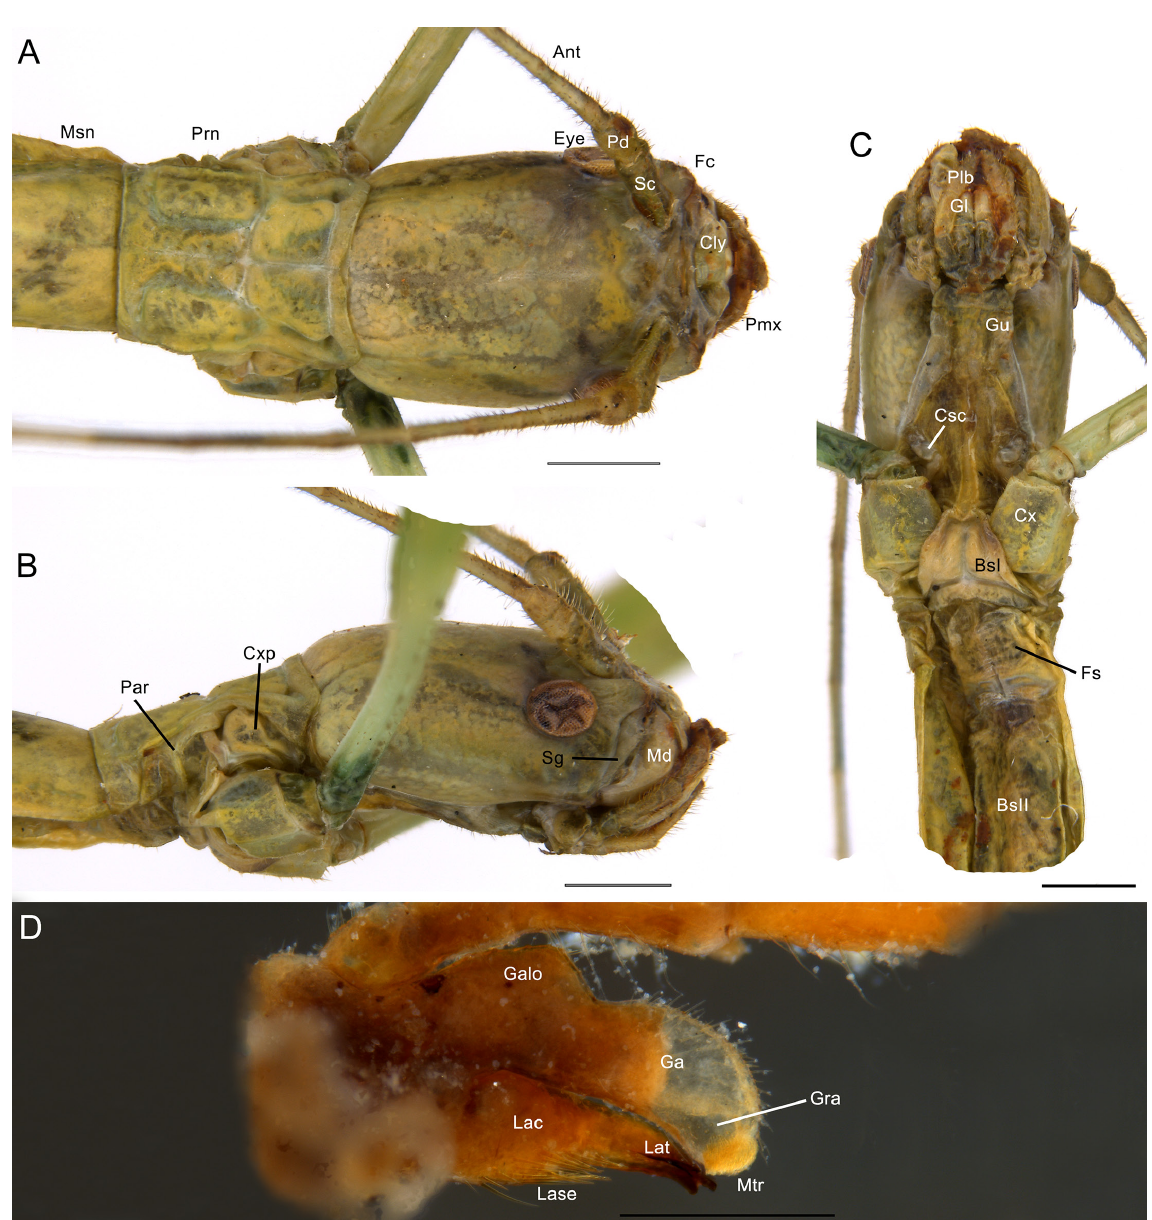
Fig. 21. Arumatia crassicercata Ghirotto, Crispino & Engelking gen. et sp. nov., head and prothorax morphology. A–C . Holotype, ♀ (MZUSP 0812). D . Paratype (MZUSP 0871). A . Head and prothorax in dorsal view. B . Head and prothorax in lateral view. C . Head and prothorax in ventral view. D . Right maxilla, dorsal (internal) view. Abbreviations: Ant = antennomere; BsI-II = pro- and mesothoracic basisterna; Cly = clypeus; Csc = cervical sclerite; Cx = coxa; Cxp = coxopleurite; Eye = compound eye; Fc = frontal convexity; Fs = prothoracic furcasternite; Ga = galea; Galo = galealobulus; Gl = glossa; Gra = granules; Gu = gula; Lac = lacinia; Lase = lacinial setae; Lat = lacinial teeth; Md = mandible; Msn = mesonotum; Mtr = microtrichia; Par = paranota; Pd = pedicellus; Plb = labial palpus; Pmx = maxillary palpus; Prn = pronotum; Sc = scapus; Sg = subgena. Scale bars: A–C = 1 mm; D = 0.5